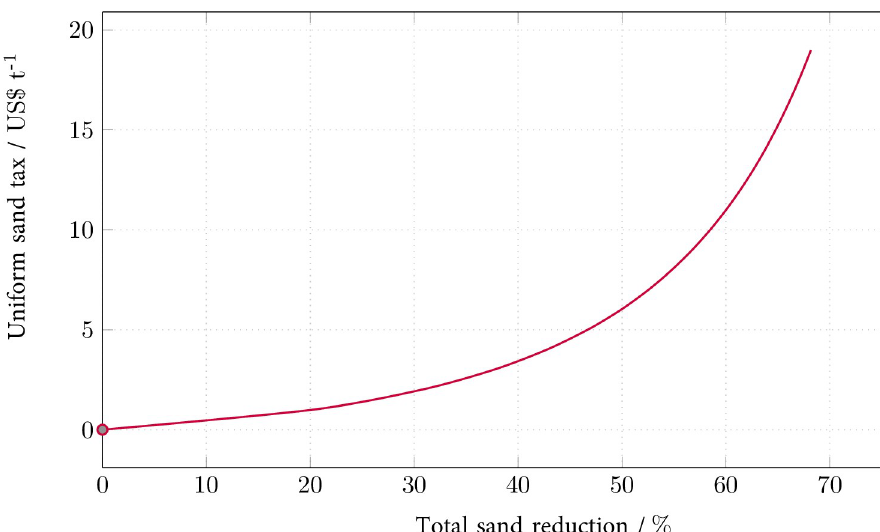
Fig 1. Tax rate (marginal reduction cost) as a function of the total reduction of sand extraction under the output tax (OutTax).